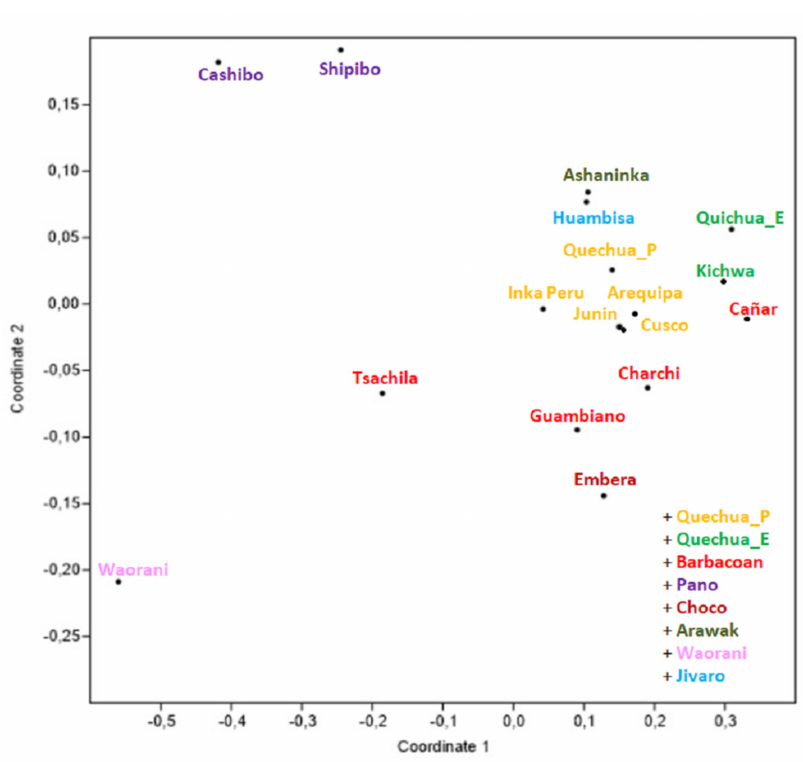
Figure 5. MDS plot based on F st genetic distances (stress value = 0.079) among 17 Ecuadorian, Peruvian, and Colombian